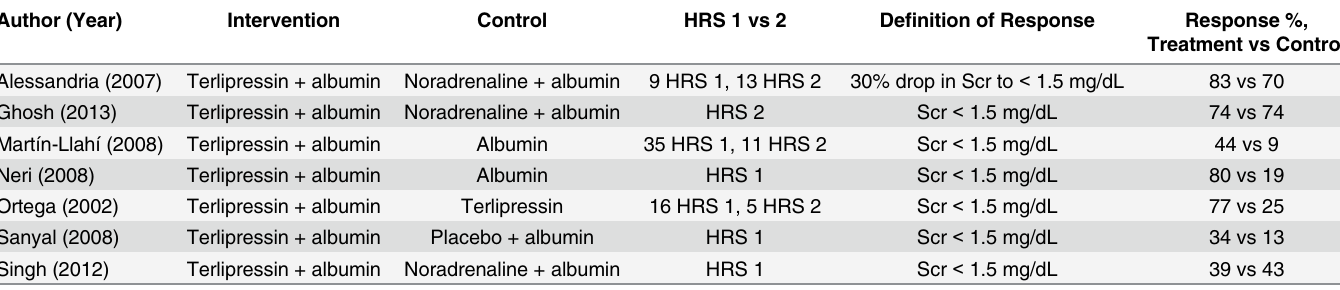
Table 1. General Characteristic of Included